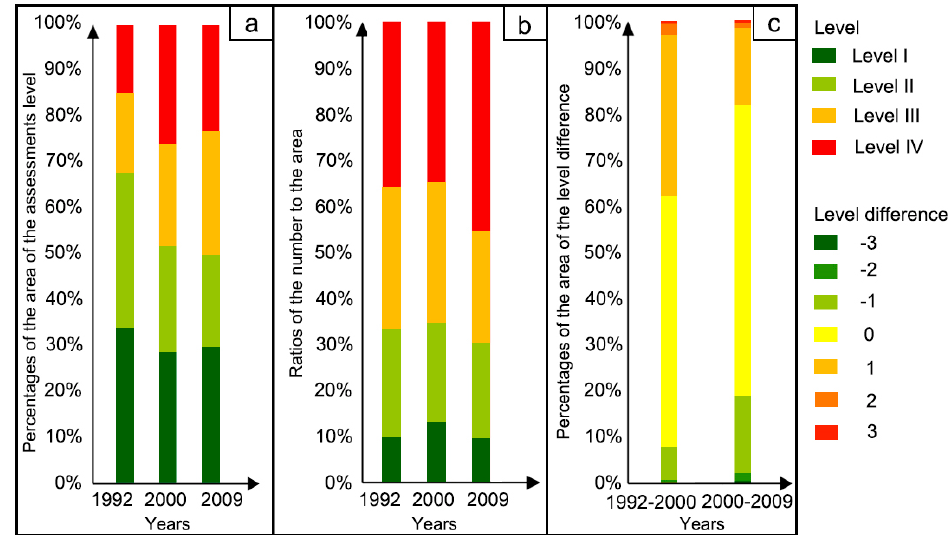
Figure 10. Comprehensive comparison of the percentages of ( a ) the assessment levels, ( b ) the RNA values of various assessment levels, and ( c ) the level differences.